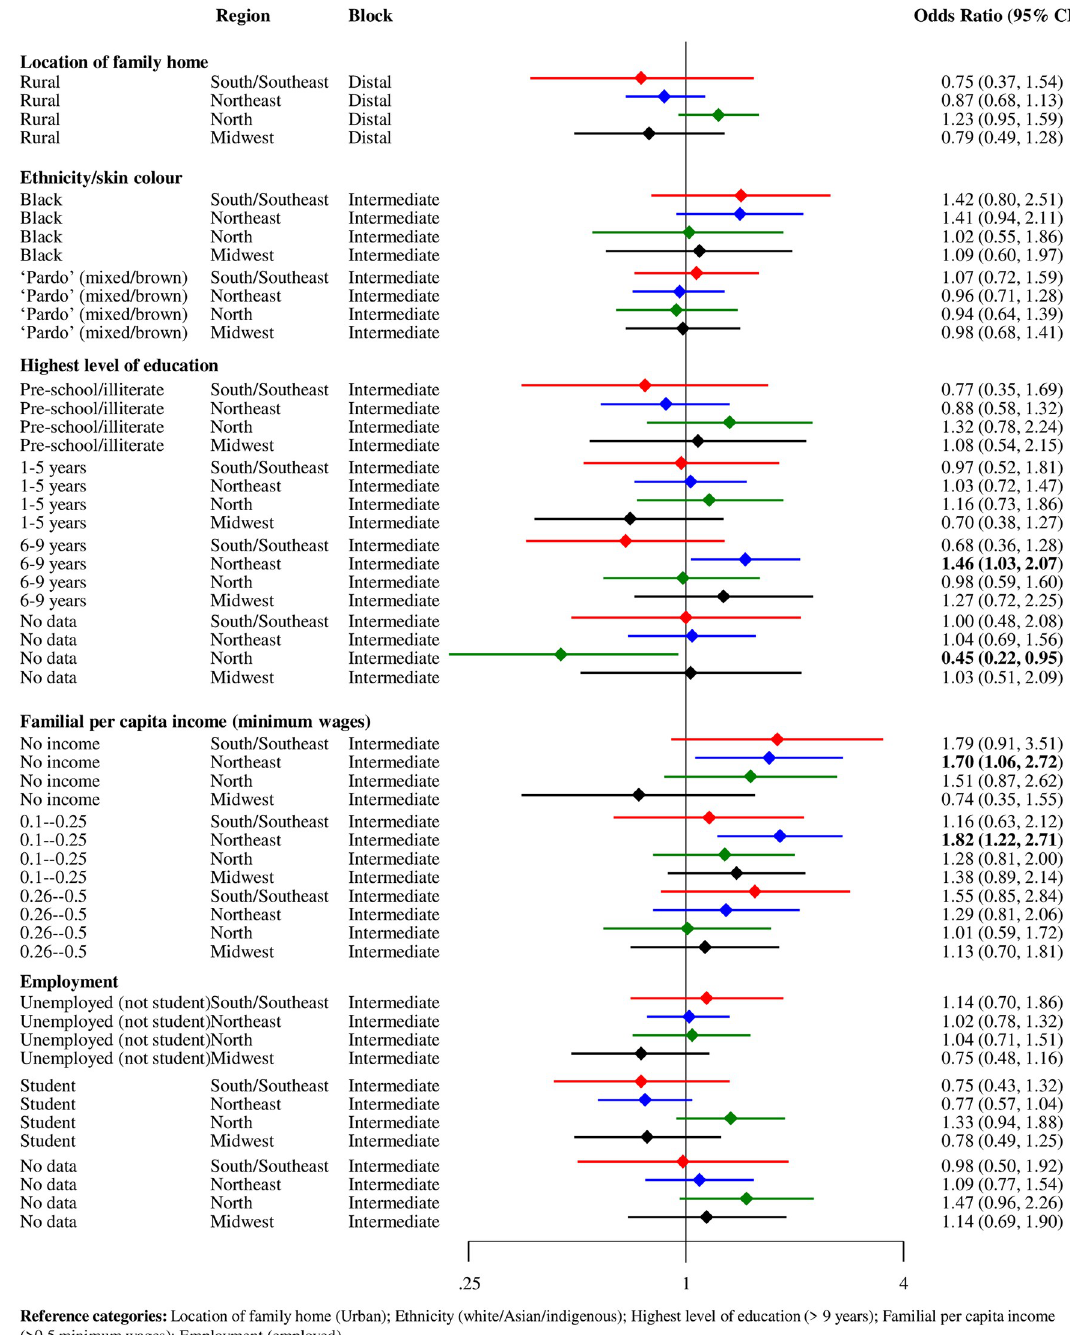
Fig 5. Forest plot of hierarchical association of distal and intermediate factors with leprosy treatment default (N = 20,063), stratified by Brazilian regions, Brazil, 2007–2014.